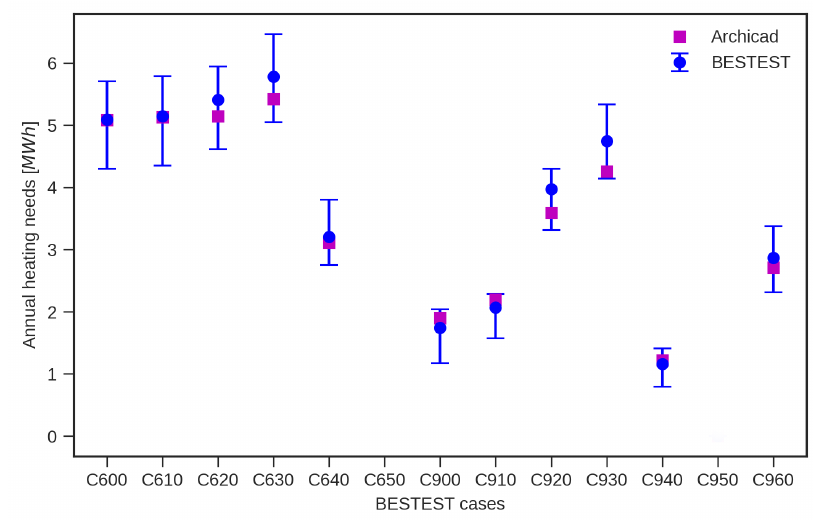
Figure 6. BESTEST results for Archicad Energy Evaluation tool for annual heating energy (MWh).